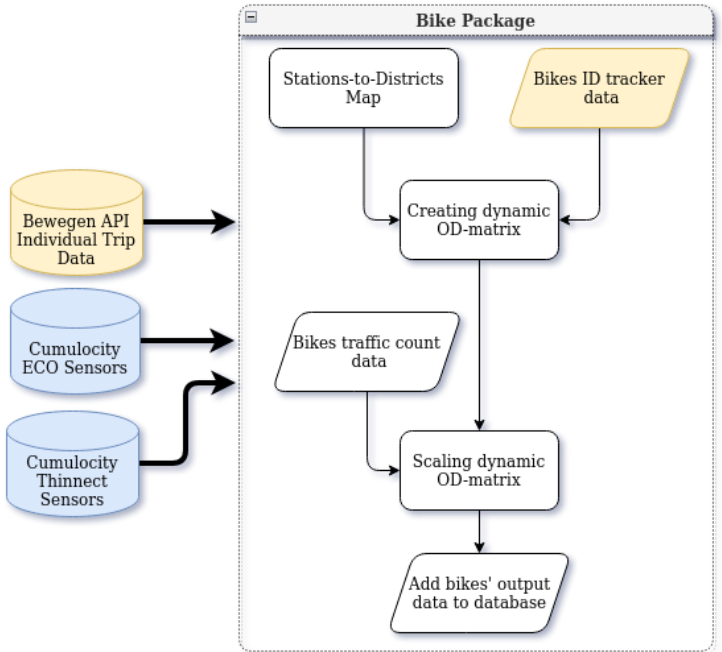
Figure 3. Bicycle package